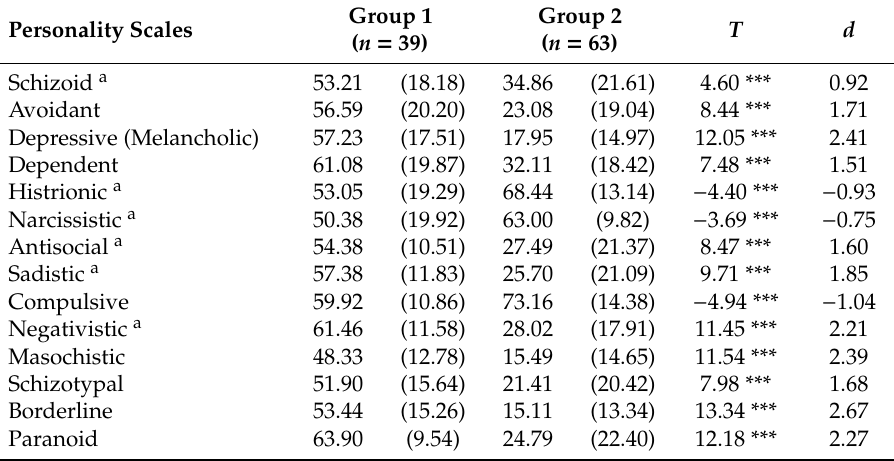
Table 2. Mean base rate (BR) scores on the personality scales (standard deviation in brackets) for the two groups (clusters) and value of t -test (or Welch’s t -test) and Cohen’s d